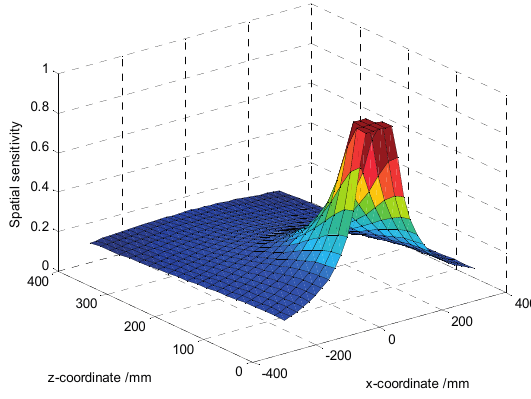
Figure 4. Variations of the spatial sensitivity with x and z .